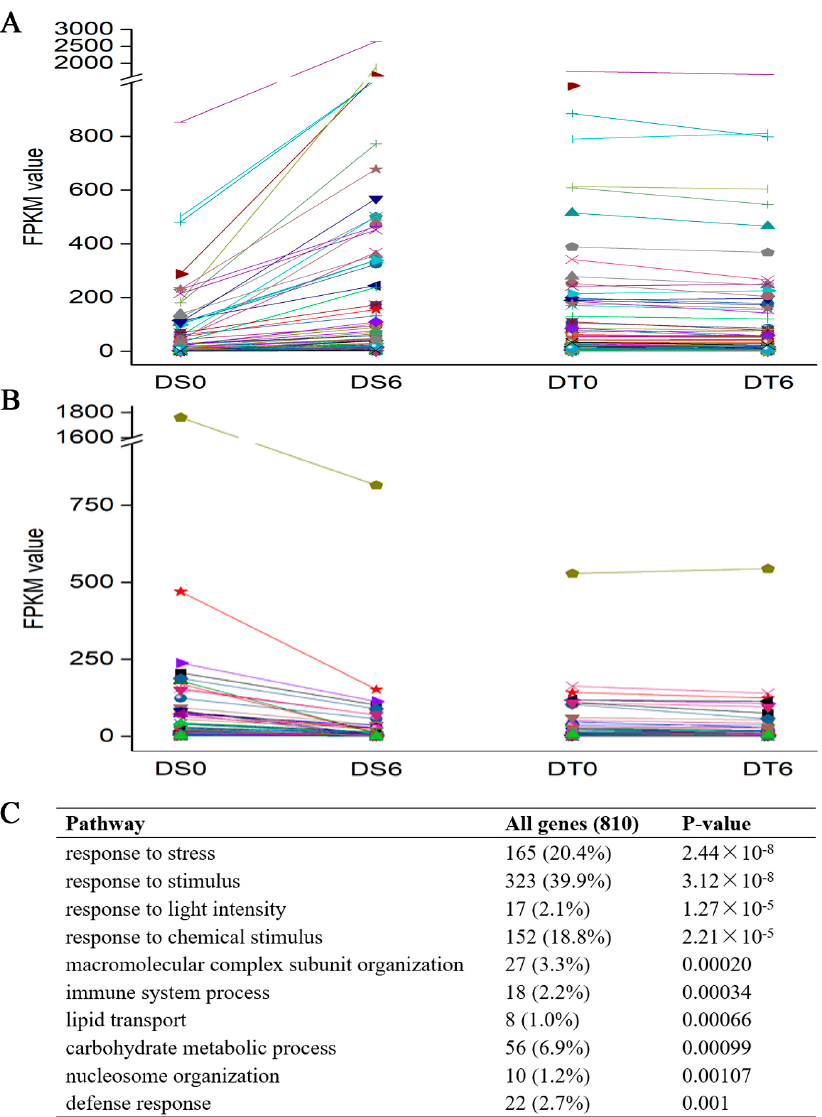
Figure 7. Analysis of stress-responsive genes that were differentially expressed (DEGs: FDR < 0.05 and absolute log 2 fold change ≥ 1) in DS seeds following drying. ( A ) Expression levels of stress- responsive genes that were significantly up-regulated, and ( B ) significantly down-regulated in DS seeds following drying. ( C ) The top 10 enriched GO categories of DEGs (DS0 vs. DS6). DS0 signifies desiccation-sensitive seeds dried for 0 d; DS6, desiccation sensitive seeds dehydrated for 6 d; DT0, desiccation tolerant seeds dried for 0 d; and DT6, desiccation tolerant seeds dehydrated for 6d. The color lines represents the trend of gene changes from 0 d to 6